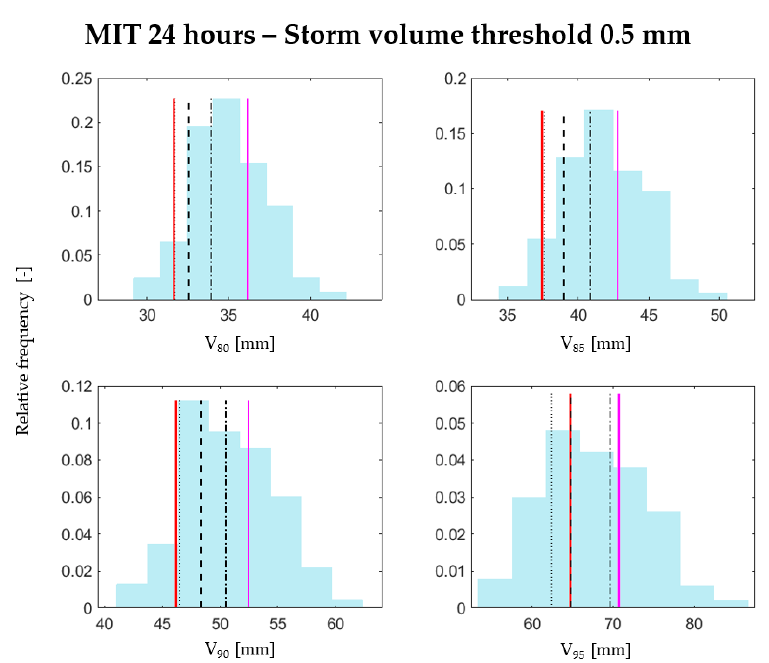
Figure 7. Relative frequency of volumetric percentiles that treat a percentage of the total volume of accumulated rainfall series, for MIT 24 h and storm volume threshold 0.5 mm. Red and magenta lines represent respectively observed rainfall series with time-step 15 min and 24-h. Black dashed, dotted and dash-dotted lines represents respectively the median, 25th and 75th percentiles of simulated data (light cyan bars).